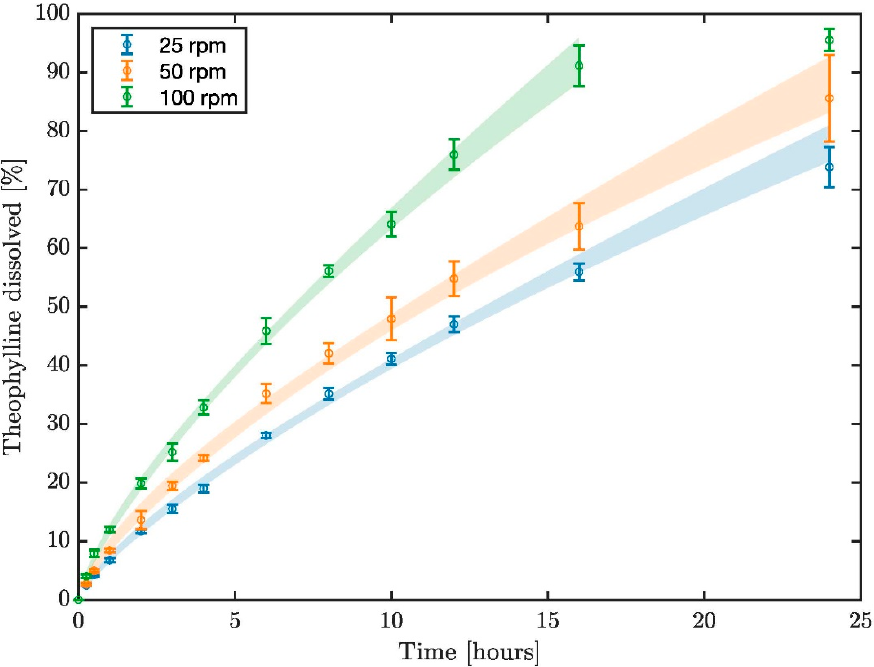
Figure 3. Dissolution profiles of theophylline from Uniphyllin Continus (UC) 200 mg tablets in the USPII apparatus at 25, 50 and 100 rpm.